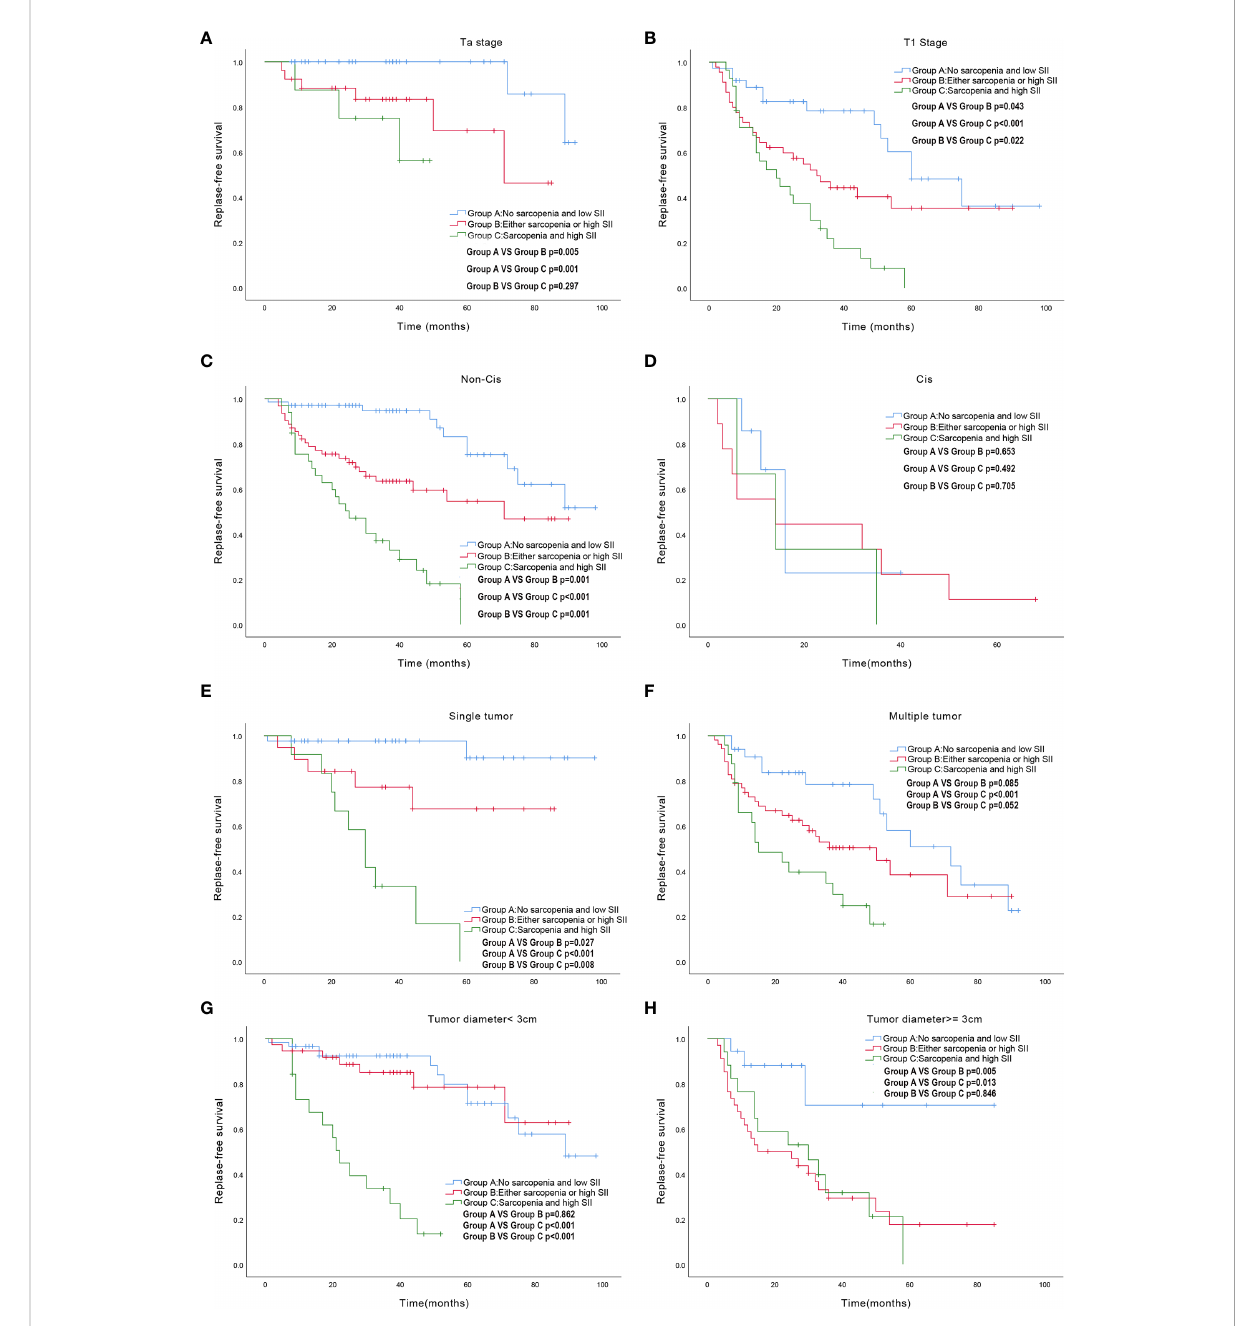
FIGURE 6 Subgroup survival analysis exploring the effect of sarcopenia accompanied by high SII on RFS. (A) Ta stage subgroup; (B) T1 stage subgroup; (C) Non-CIS subgroup; (D) CIS subgroup; (E) single tumor subgroup; (F) multiple tumor subgroup; (G) tumor diameter<3cm subgroup; (H) tumor diameter>=3cm subgroup. SII: Systemic Immune-In fl ammation Index; RFS: Relapse-free survival; CIS: Carcinoma in